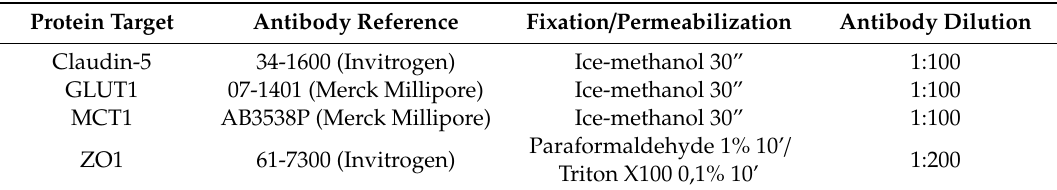
Table 1. Antibodies used for the immunostaining experiment.